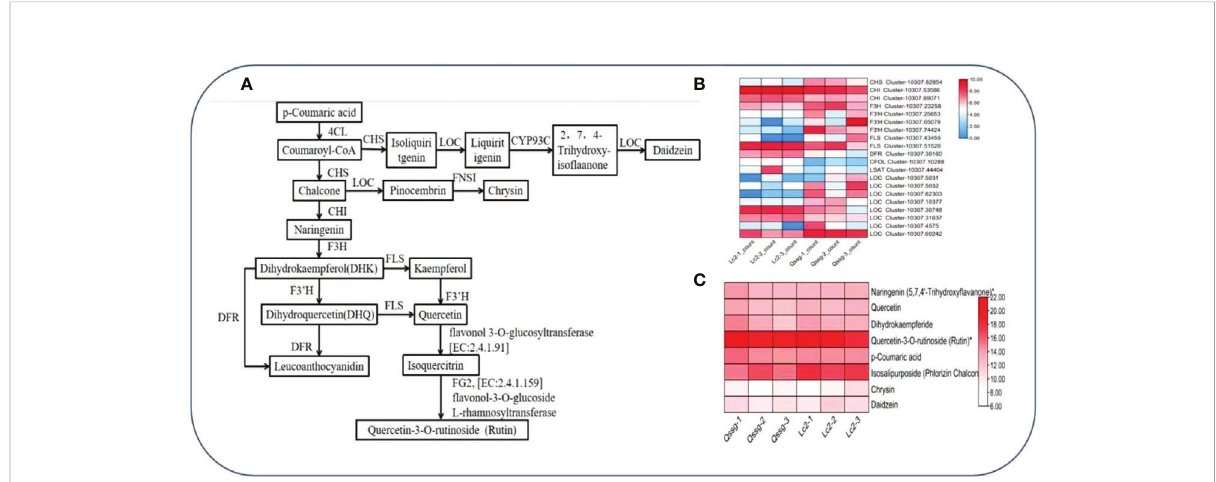
FIGURE 7 Flavonoid biosynthesis pathway.Metabolite content and regulatory structure gene network in Qssg and Lc fruits. (A) Biosynthetic pathway of Rutin, Chrysin, and Daidzein in Qssg and Lc fruits. (B) Determination of gene expression in Rutin, Chrysin, and Daidzein biosynthesis pathway in Qssg and Lc fruits. (C) Determination of metabolites in Rutin, Chrysin, and Daidzein biosynthesis pathway of Qssg and Lc